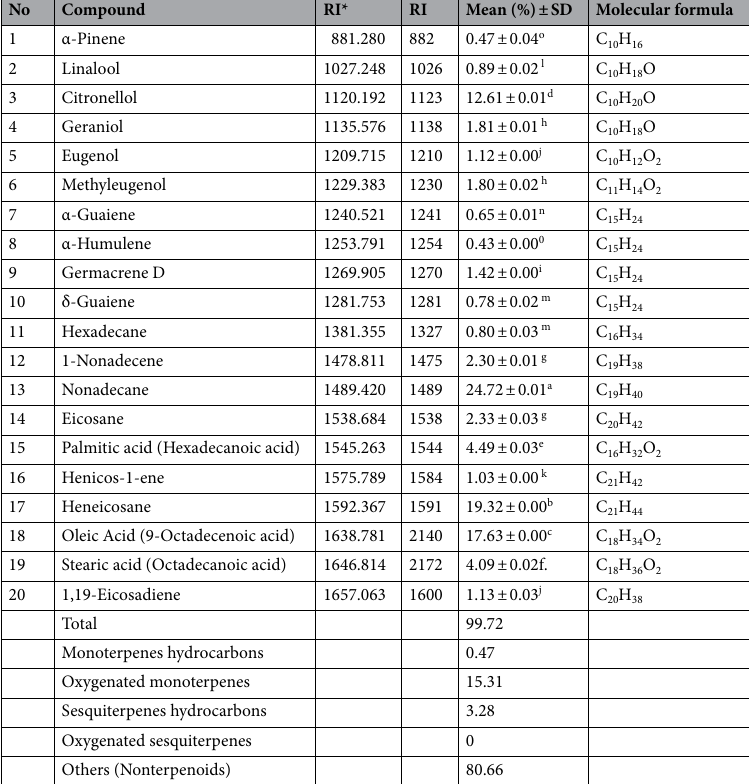
Table 1. The chemical composition of essential oil of R. damascena. RI refers to the retention index identified by database NIST 014; RI*refers to the retention index calculated from the retention time relative to that of C8 – C40 n-alkanes; Values with different letters are statistically different (Duncan, p ≤